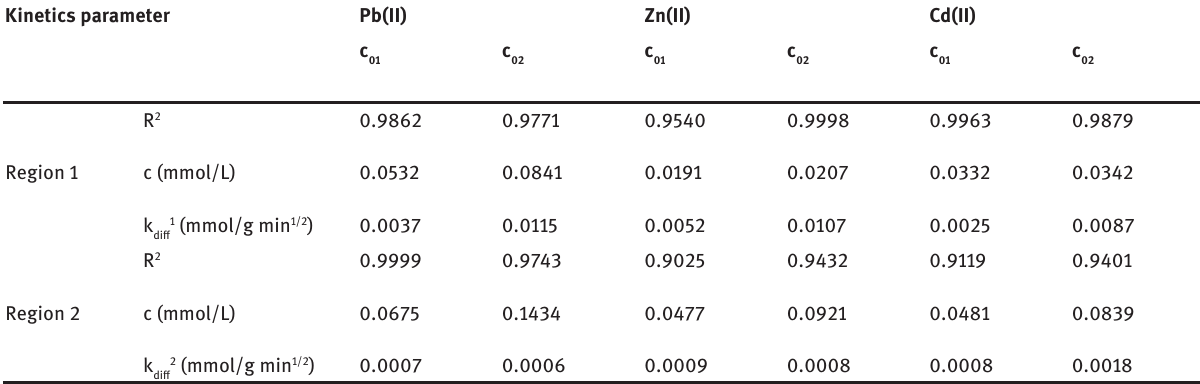
Figure 5: Intra-particle diffusion kinetics for biosorption of Pb(II), Zn(II) and Cd(II) onto mustard waste biomass at 20 °C. Table 4: Kinetic parameters of an intra-particle diffusion model for the biosorption of Pb(II), Zn(II) and Cd(II)onto mustard waste biomass. Kinetics